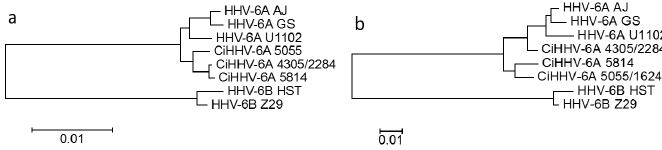
Figure 2. Phylogenetic tree analyses of CiHHV-6A and Herpesviridae , conserved core and variable genes. Maximum likelihood method was used in Mega 5.1 using Bestfit model of General Time Reversible with gamma distribution (methods) with maximized amino acid alignment followed by back-translation and phylogenetic reconstruction. ( a ) Conserved core genes were compared showing relationships. These included 14 genes encoding mainly HHV-6A/B conserved structural and DNA replication components and included U31-39, U42-44, U74, U81-82; ( b ) Variable genes as defined in Table 1, included 16 genes and were compared to homologues in genomes of strains of HHV-6A/B virus. Bootstrapping (1000) shows percentage of trees where taxa cluster together were >95% for all nodes. The scales shows branch lengths measured in number of substitutions per site. HHV-6B was used as an out-group to analyze relationships between HHV-6A and CiHHV-6A.